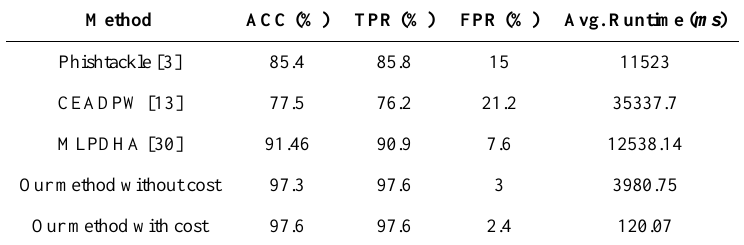
Table 4. Comparison of suggested test results with those of other anti-phishing